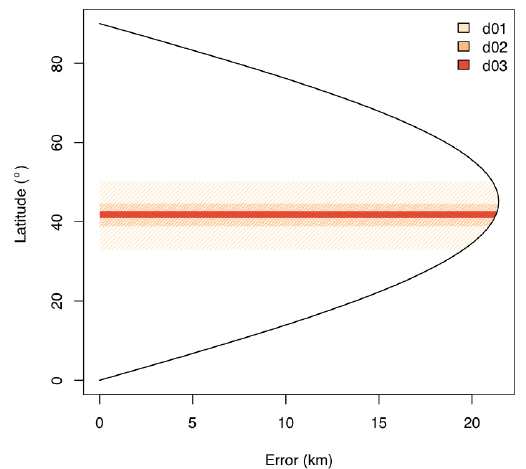
Figure 2. Errors introduced by the different geographic coordinate systems are a function of latitude. The maximum error of about 21km is found at 45 ◦ latitude. The three shaded areas indicate the latitudinal extents of the three nested WRF domains used in this study.